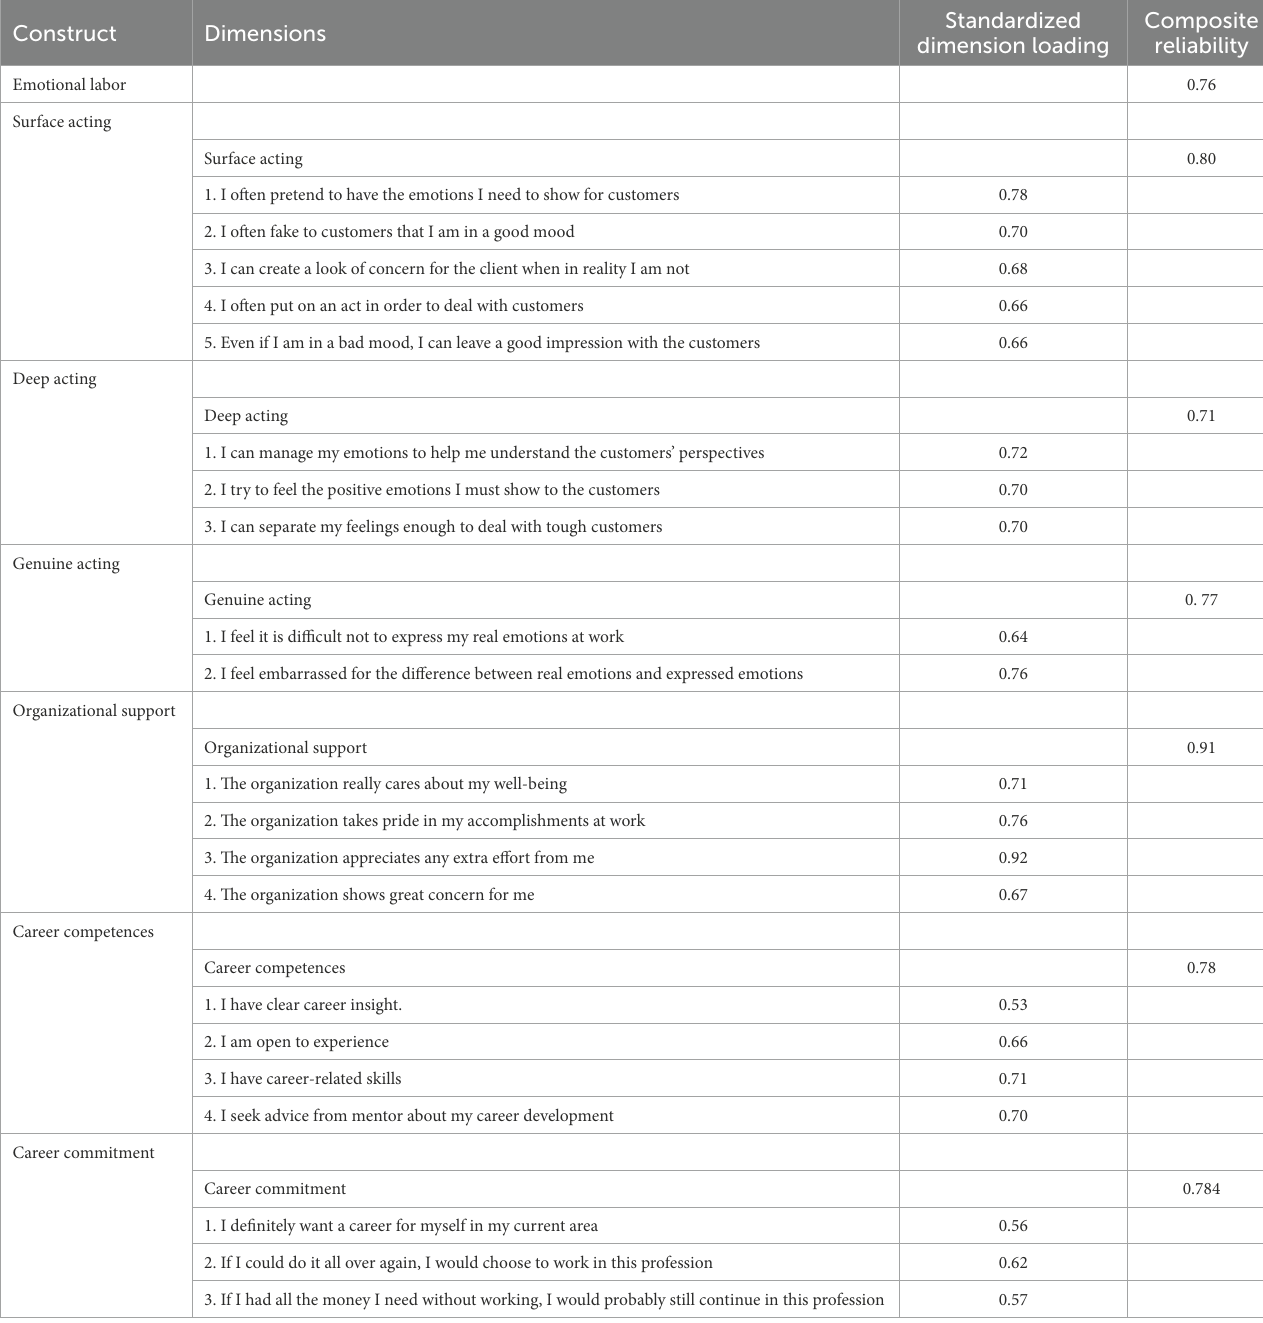
TABLE 1 Confirmatory factor analysis of dimensions of examined factors ( N =